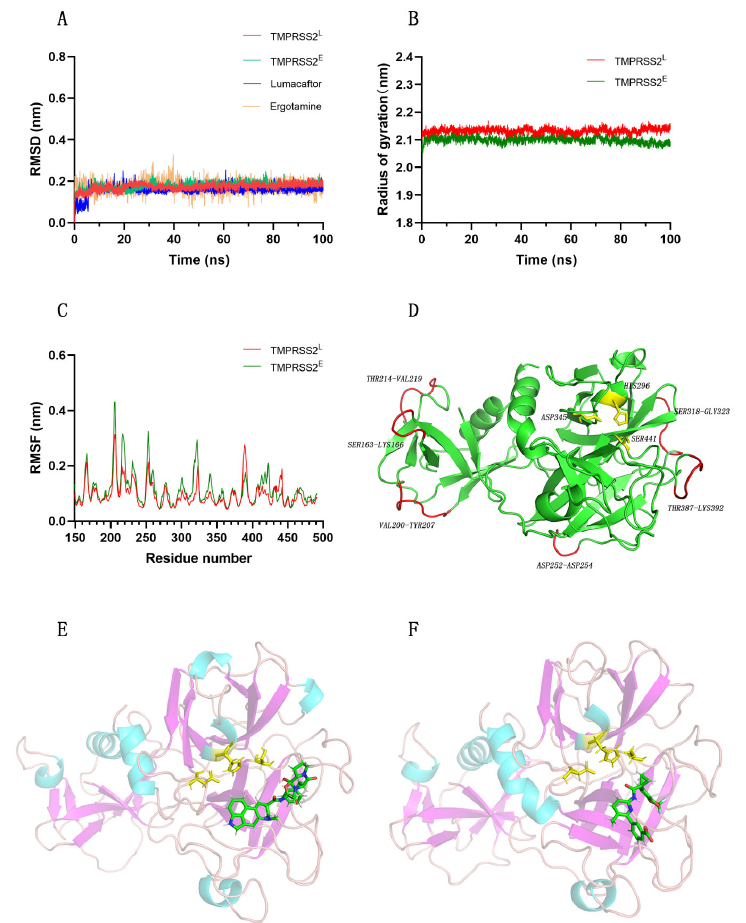
Figure 3. Schematic representation of RMSD ( A ), radius of gyration ( B ), and RMSF ( C ) of the systems during 100 ns MD simulations. ( D ) Flexible amino acid residues and active sites during the 100 ns MD simulation. TMPRSS2E/L represents the protein structure of the complex of TMPRSS2 with ergotamine or lumacaftor. Structures in red are amino acid residues with increased freedom, while bars in yellow represent active sites of TMPRSS2. Binding region of ergotamine ( E ) or lumacaftor ( F ) with TMPRSS2.